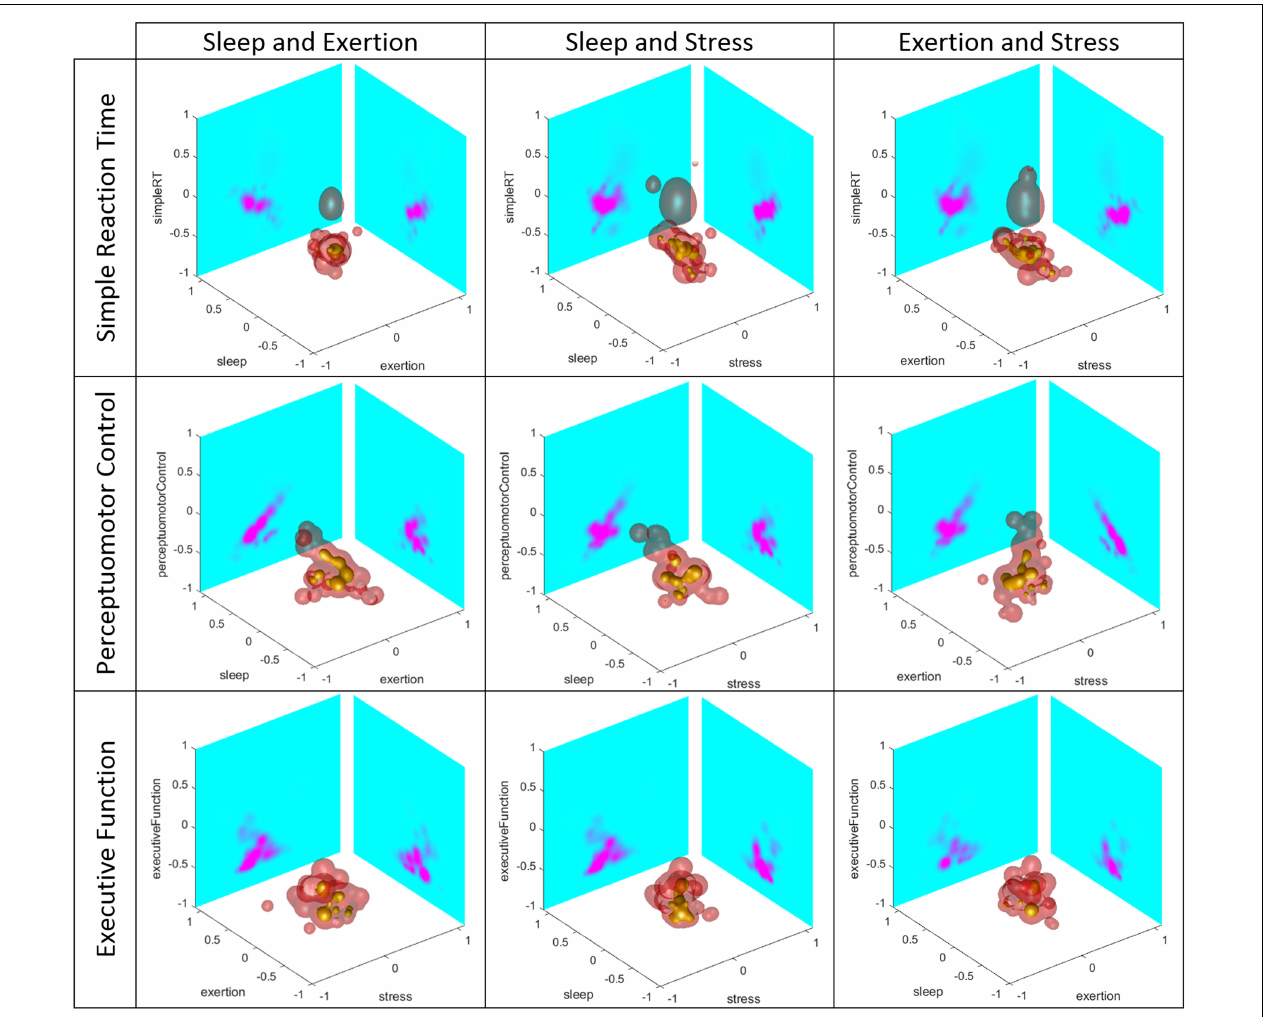
FIGURE 2 | Three-dimensional (3D) slices of the dependent (rows) and pairs of independent (columns) variables. In each panel, we plot the 3D iso-contours at levels 1, 10, and 50% of maximum value in yellow, red, and gray, respectively. The yellow “blobs” indicate the areas of highest probability density in the 3D space, with the red and gray volumes providing an indication as to how the probability is spread. We also display in pink/cyan shades the two dimensional distributions of the dependent and each independent variable with strong pink shades indicating regions of high probability density; these colormaps were saturated at a value of 10% of maximum value to better display the variability in the distribution